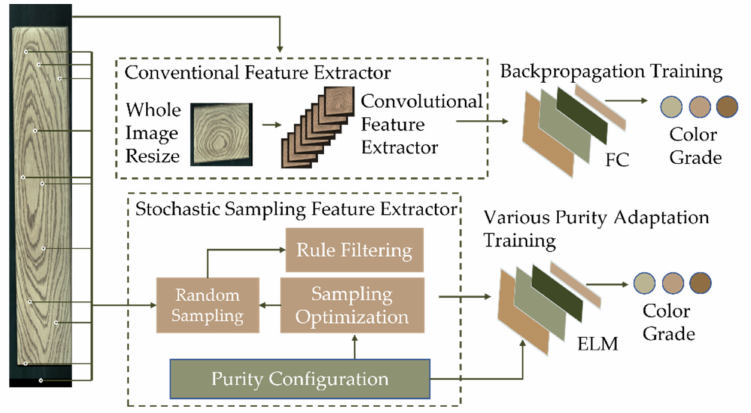
Figure 4. Difference between convolutional feature extractor and the proposed stochastic sampling feature extractor. FC: fully connected